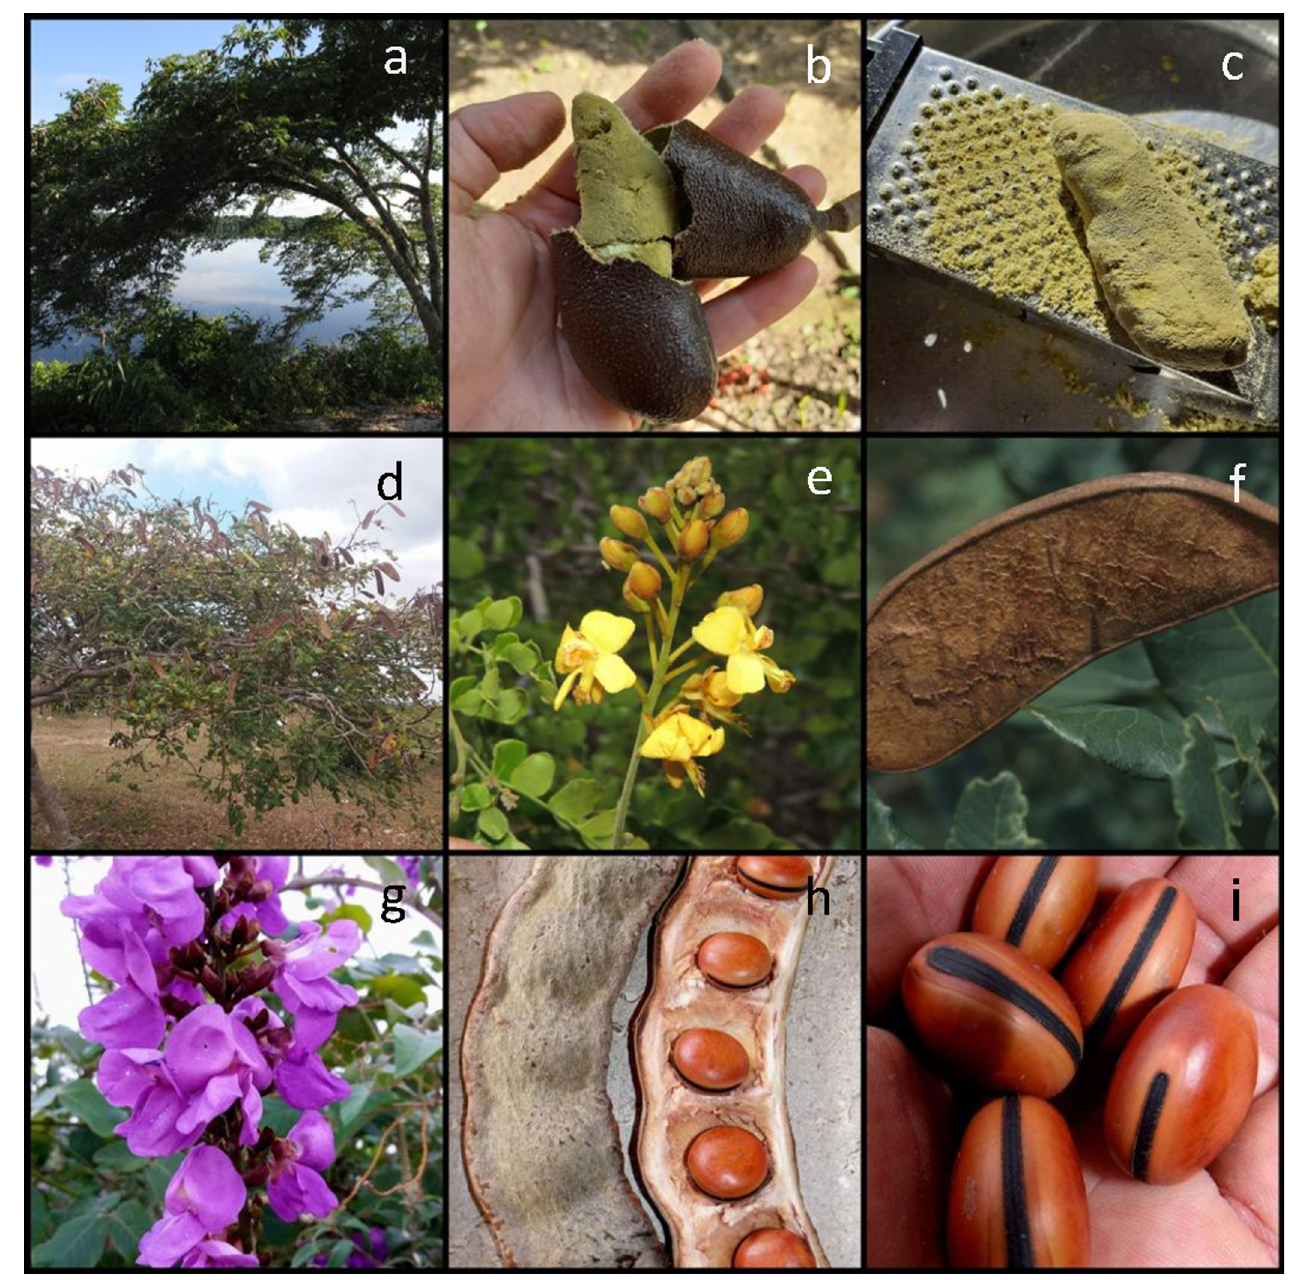
Fig 2. Tree Legumes analyzed in our review. (a) Tree, (b) whole fruit, and (c) extraction of pulp fruit of Hymenaea courbaril , by Gabriela Gonc¸alves. (d) Tree, (e) flower, and (f) whole fruit of Libidibia ferrea , by Rocicler Silva, Kew Science, and Rubes Queiroz, respectively. (g) Flower, (h) whole fruit, and (i) seeds of Dioclea grandiflora , by Gilda´sio